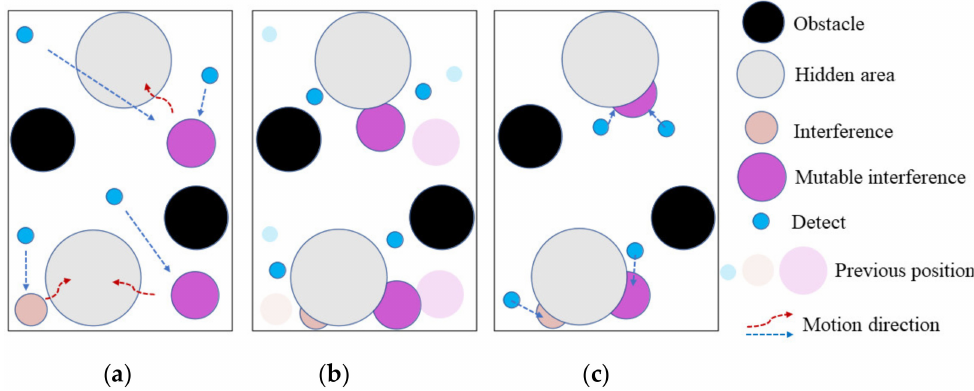
Figure 8. Tracking experiment after mutation of purple interference agents (tracking experiment 2): ( a ) shows the motion trend of each agent, ( b ) shows the action of each agent, and ( c ) shows the results after each agent action.